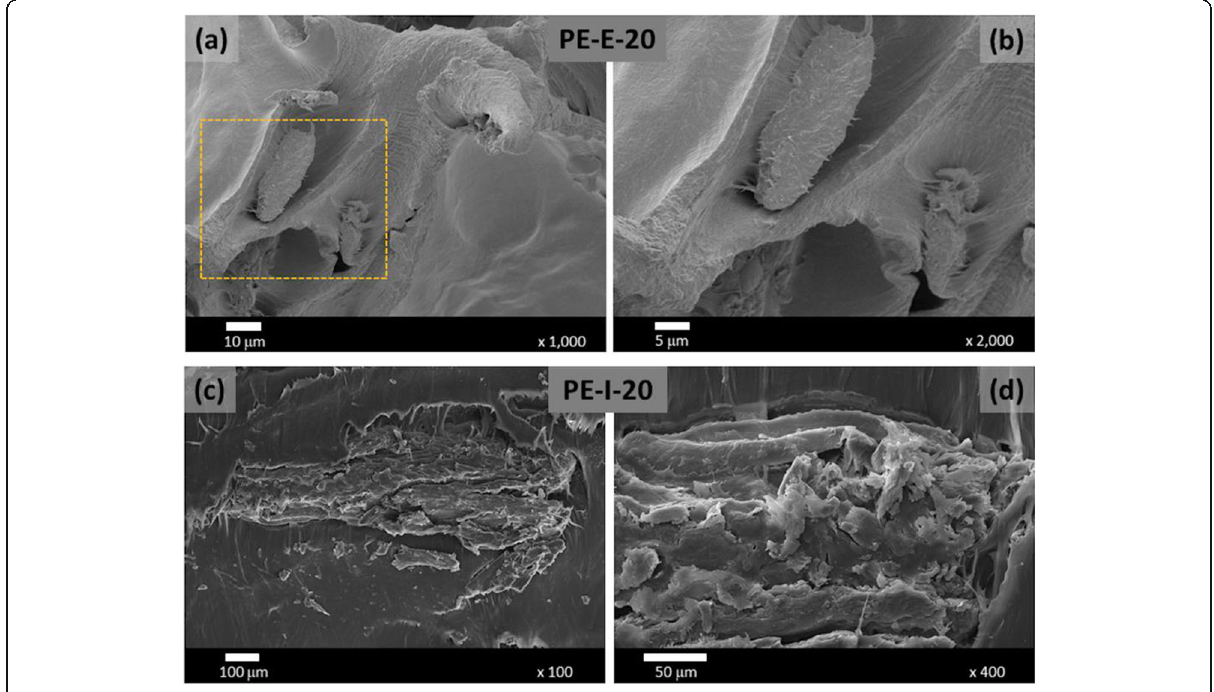
Fig. 4 SEM images of PE-E-20 (a, b) and PE-I-20 (c, d) eco –